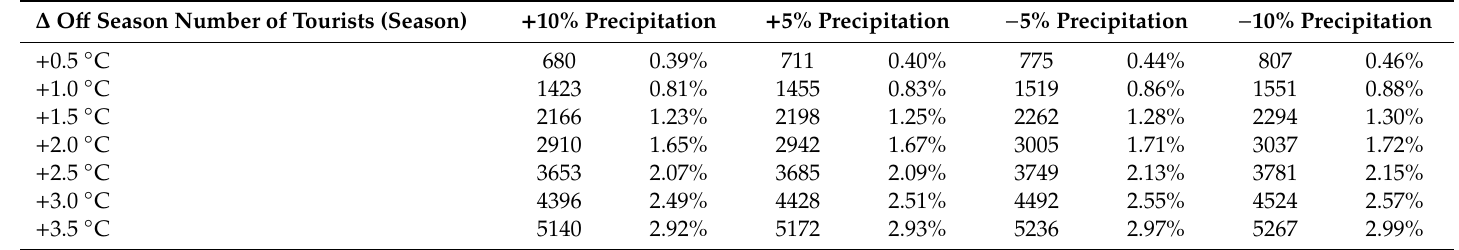
Table 8. O ff season number of tourists increase (persons per season) and increate rate (%). ∆ O ff Season Number of Tourists (Season)